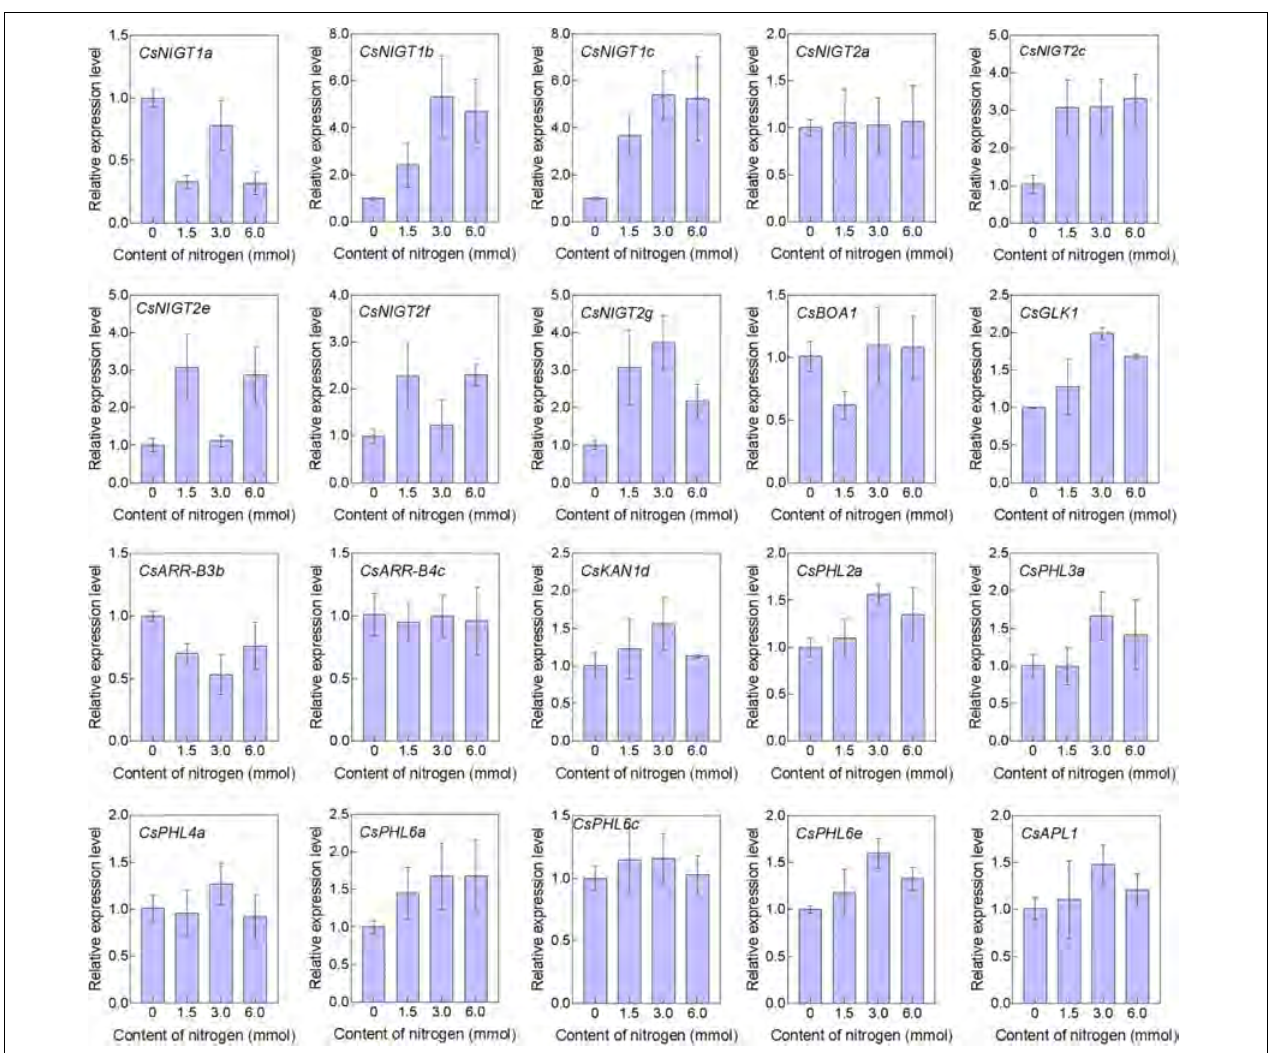
FIGURE 13 | Expression analysis of CsGARPs under nitrogen treatment. The relative expression levels of CsGP genes were determined using qRT–PCR, and the results were calculated using the 2 − (cid:49)(cid:49) Ct method and normalized to those of the CsPTB housekeeping control